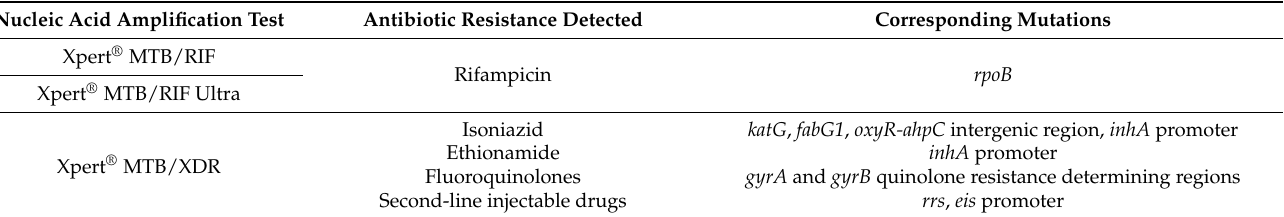
Table 1. Nucleic acid amplification tests for detecting resistance in M. tuberculosis isolates [59,60,62]. Nucleic Acid Amplification